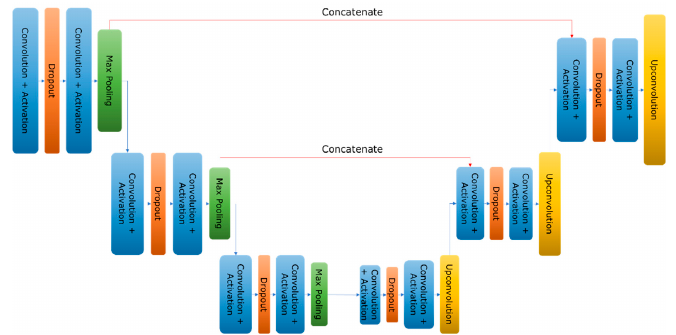
Figure 5. The general architecture of U-Net. We tested different configurations and modifications that are described in the following sections. Modified from Ronneberger et al. (2015) [13].